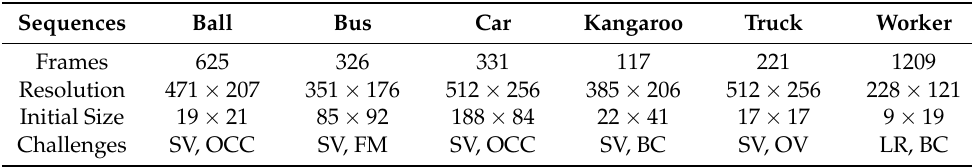
Figure 10. Six experiment sequences in RGB. ( a ) Ball; ( b ) Bus; ( c ) Car; ( d ) Kangaroo; ( e ) Truck; ( f ) Worker. Table 1. The details of six experiment